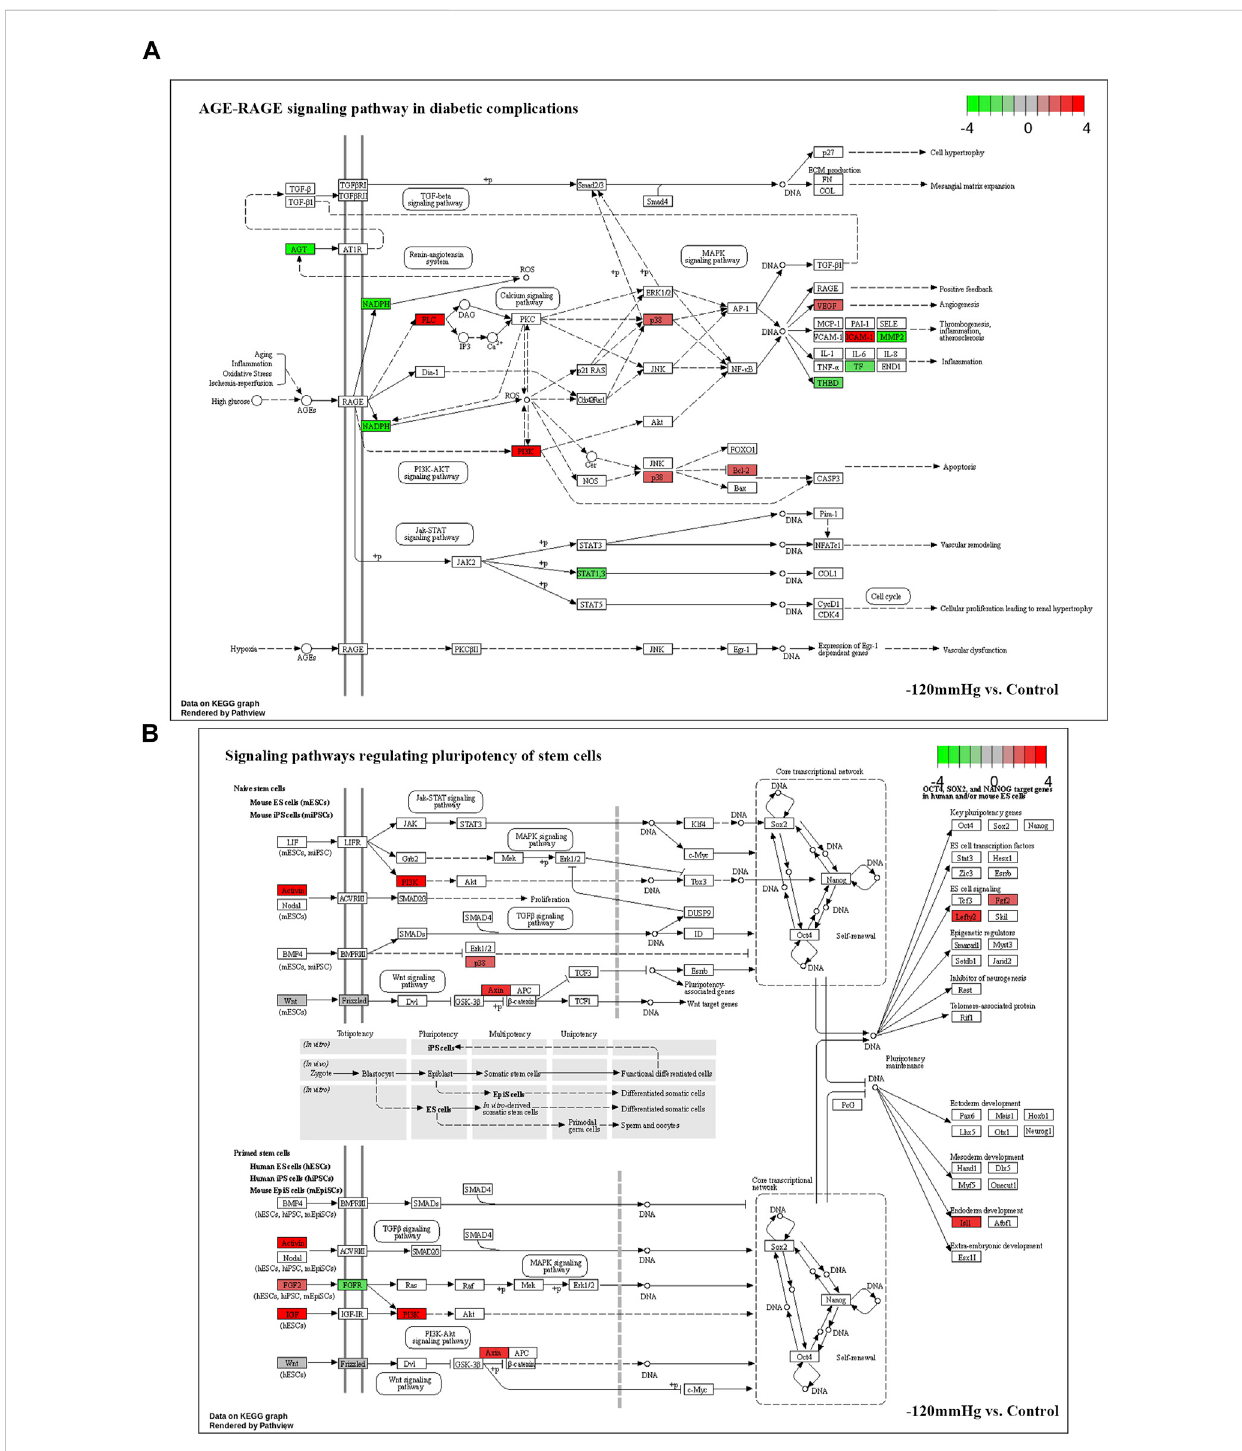
FIGURE 13 Potential activated signaling pathway under − 120mmHg treatment. (A) AGE-RAGE signaling pathway in diabetic complications. (B) Signaling pathways regulating pluripotency of stem cells.